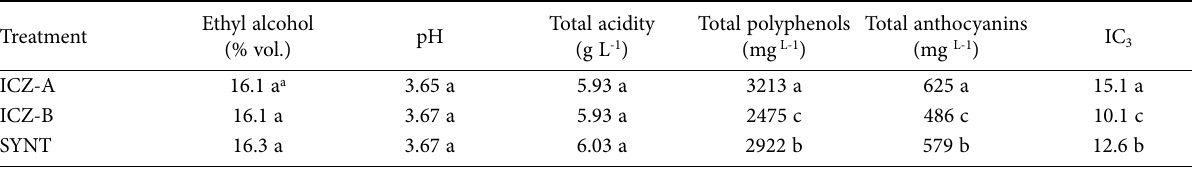
Table 10. Mean chemical composition values for Montepulciano d’Abruzzo wines obtained from cv. Montepulciano vines in the CSA vine- yard, treated in 2017 with Italian chabasite-rich zeolitites (ICZ-A and ICZ-B) or synthetic products (SYNT), after 3 months of ageing. Treatment